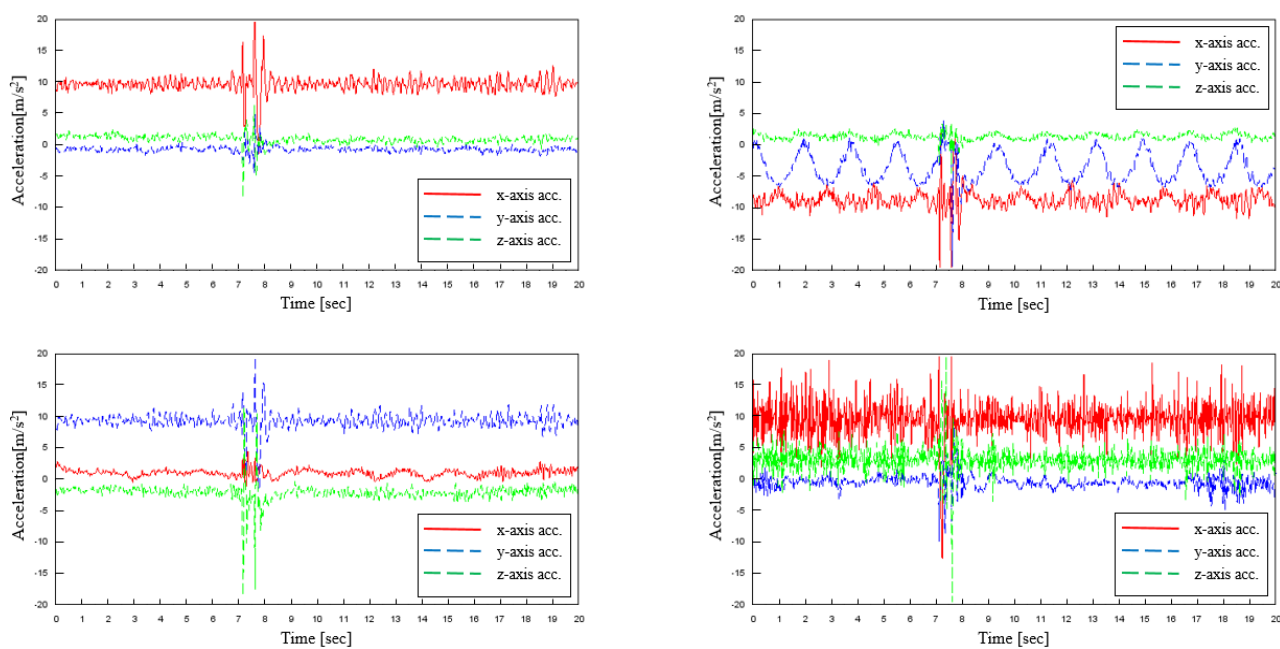
Figure 4: Acceleration signals from smartphone in four positions: hip(upper left), pants’ side pocket(upper right), shirt pocket(lower left), bag in the front basket(lower right)